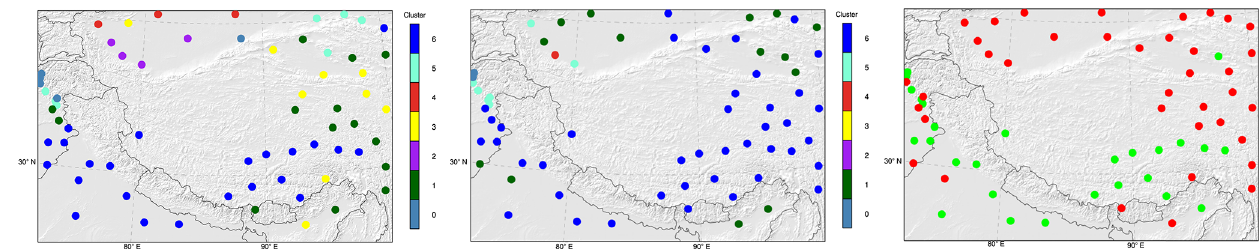
Figure 12. Map of precipitation clusters for HAR10 grid points (left) and the associated NCDC stations (middle). The map on the right shows whether the clusters match (green dots) or not (red